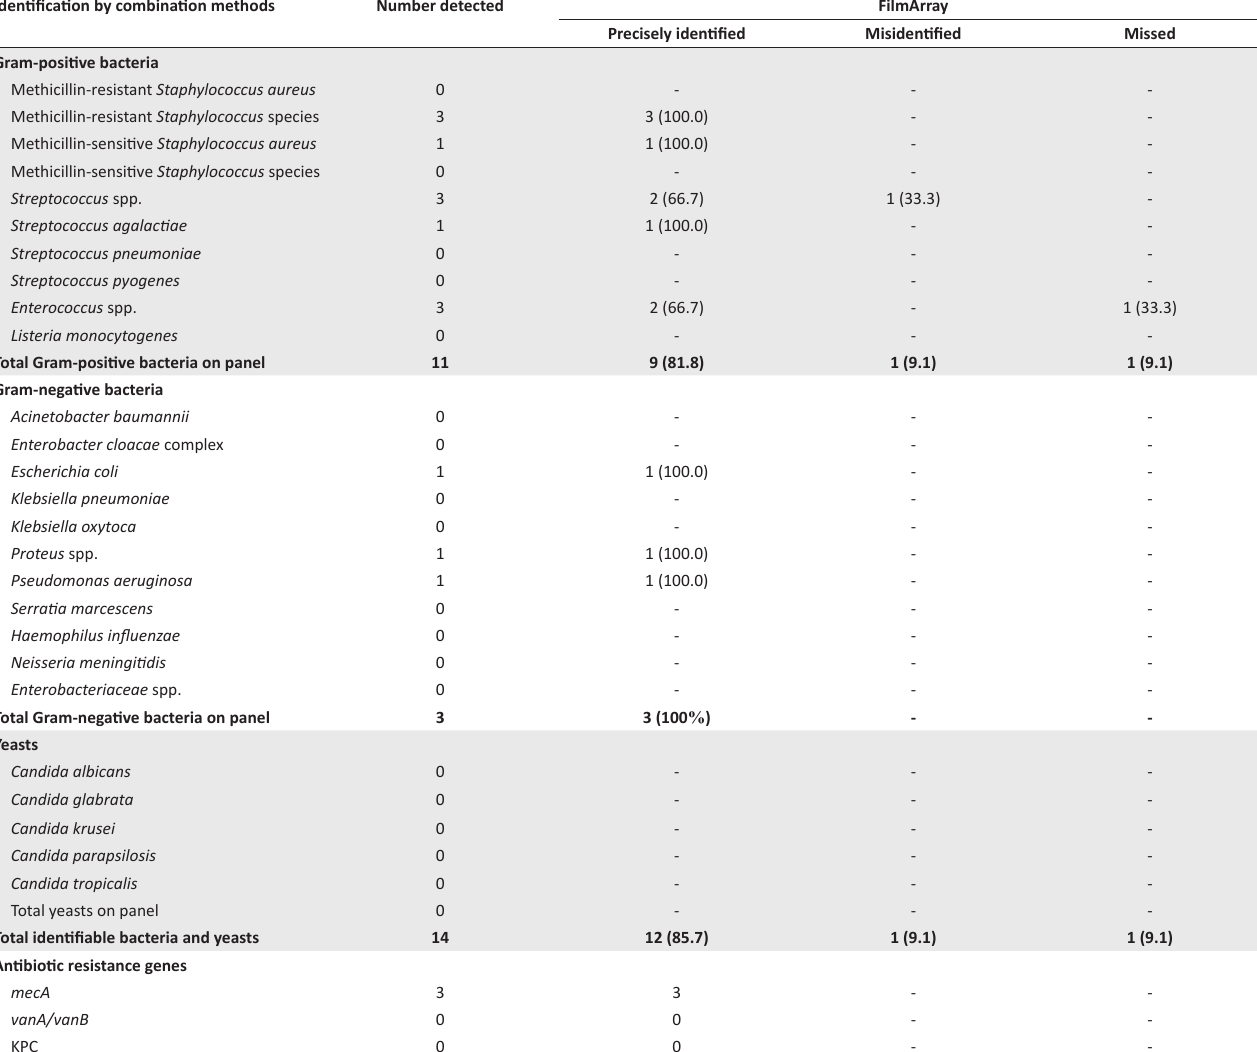
TABLE 3: Performance of FilmArray on blood cultures with more than one type of organism – by microorganism and antibiotic resistance marker. Identification by combination methods